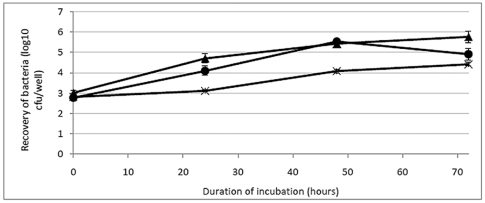
Intracellular survival of F. tularensis LVSΔ1423/1422 in J774A.1 cells.The J774A.1 monolayer (approximately 4.5×105 macrophages/well) was infected with approximately 5.5×107 CFU/well of strain LVS (•), LVSΔ1423/1422 (▴), or LVSΔ1423/1422[1423/1422+] (X). Intracellular survival of the bacteria was determined at 0, 24, 48, and 72 h post-infection, as described in Materials and Methods. Data are shown on the log scale as the average number of bacteria recovered from dilutions of lysates of J774A.1 cells. The results shown were from two experiments tested in duplicate at each time point. The slopes for intracellular growth of the bacteria as log10 CFU/well between the 24th and the 48th hour for strains LVS, LVSΔ1423/1422, and LVSΔ1423/1422[1423/1422+] were +1.44, +0.73, and +0.97, respectively.